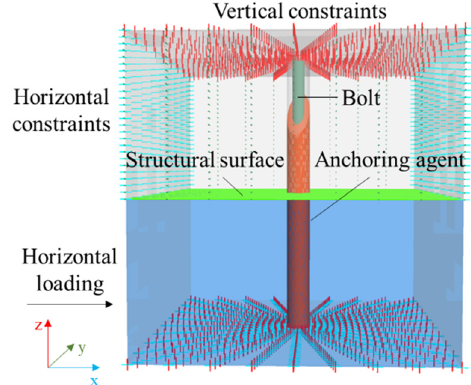
Figure 3. Boundary conditions and loading modes of the model.